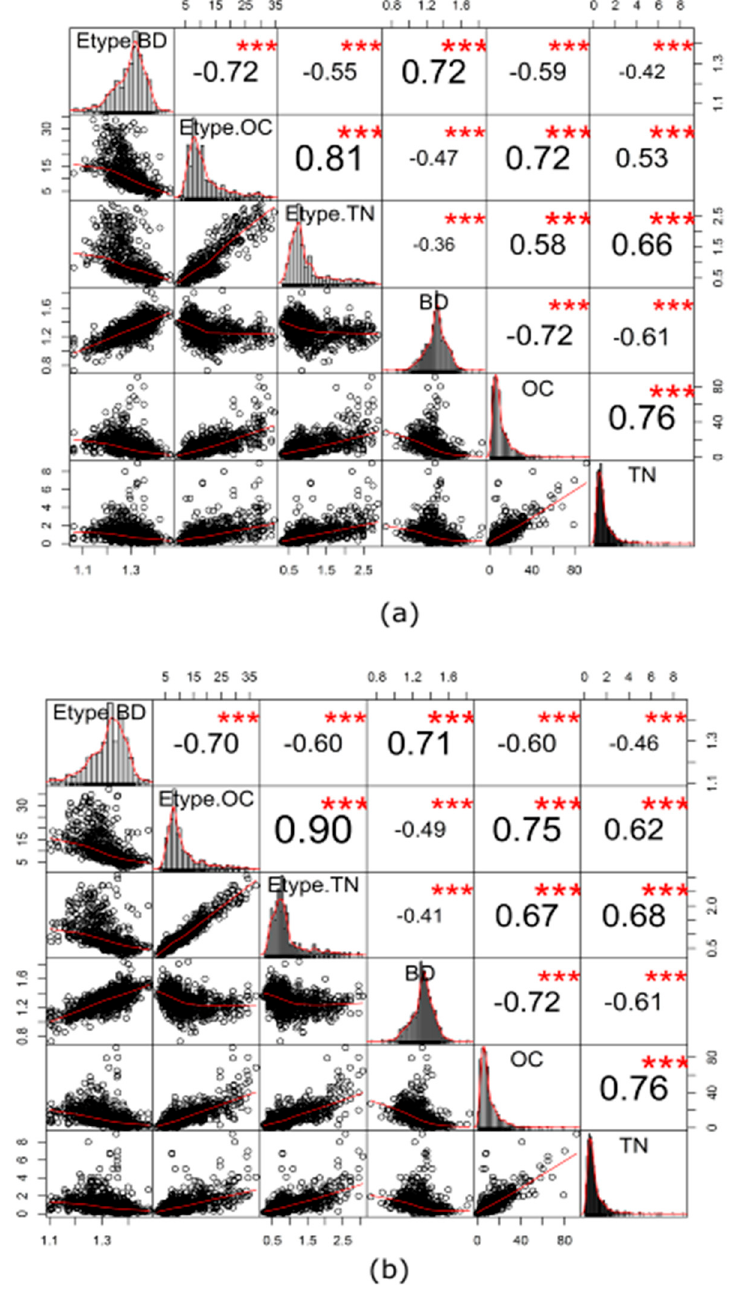
Figure 13. Cross-correlation and histogram of the E-type of back-transformed realization and original variables for ( a ) MAF and ( b ) ICA (EType.BD = average of 100 realizations for bulk density (g / cm 3 ); Etype.OC = average of 100 realizations for organic carbon (g / kg); Etype.TN = average of 100 realizations for total nitrogen (g / kg)). Semivariance is expressed in units of each variable, significance levels (*** p < 0.001)